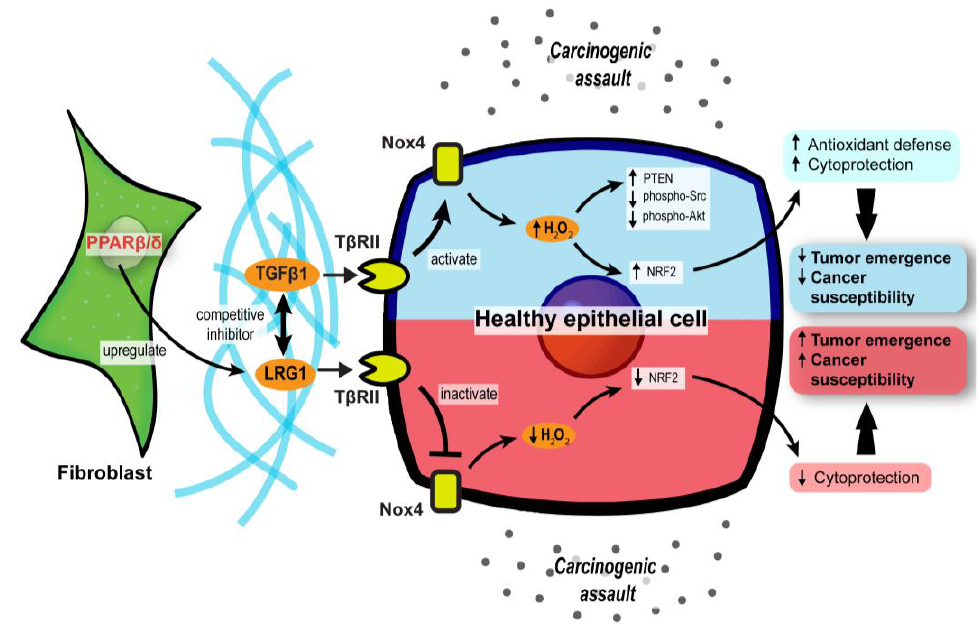
Figure 3. Stromal PPAR β / δ regulates epithelial redox homeostasis and oncogenesis. In carcinogenic assaults, TGF β signaling in epithelial cells is activated to promote H 2 O 2 synthesis, which subsequently activates NRF2 and reinforces the cytoprotection against carcinogens (blue upper compartment of the epithelial cell). However, fibroblast PPAR β / δ disrupts the protective mechanism by upregulating LRG1, which acts as a competitive inhibitor of TGF β 1 and dampens TGF β signaling, resulting in increased cancer susceptibility and oncogenesis (red lower compartment of the epithelial cell).